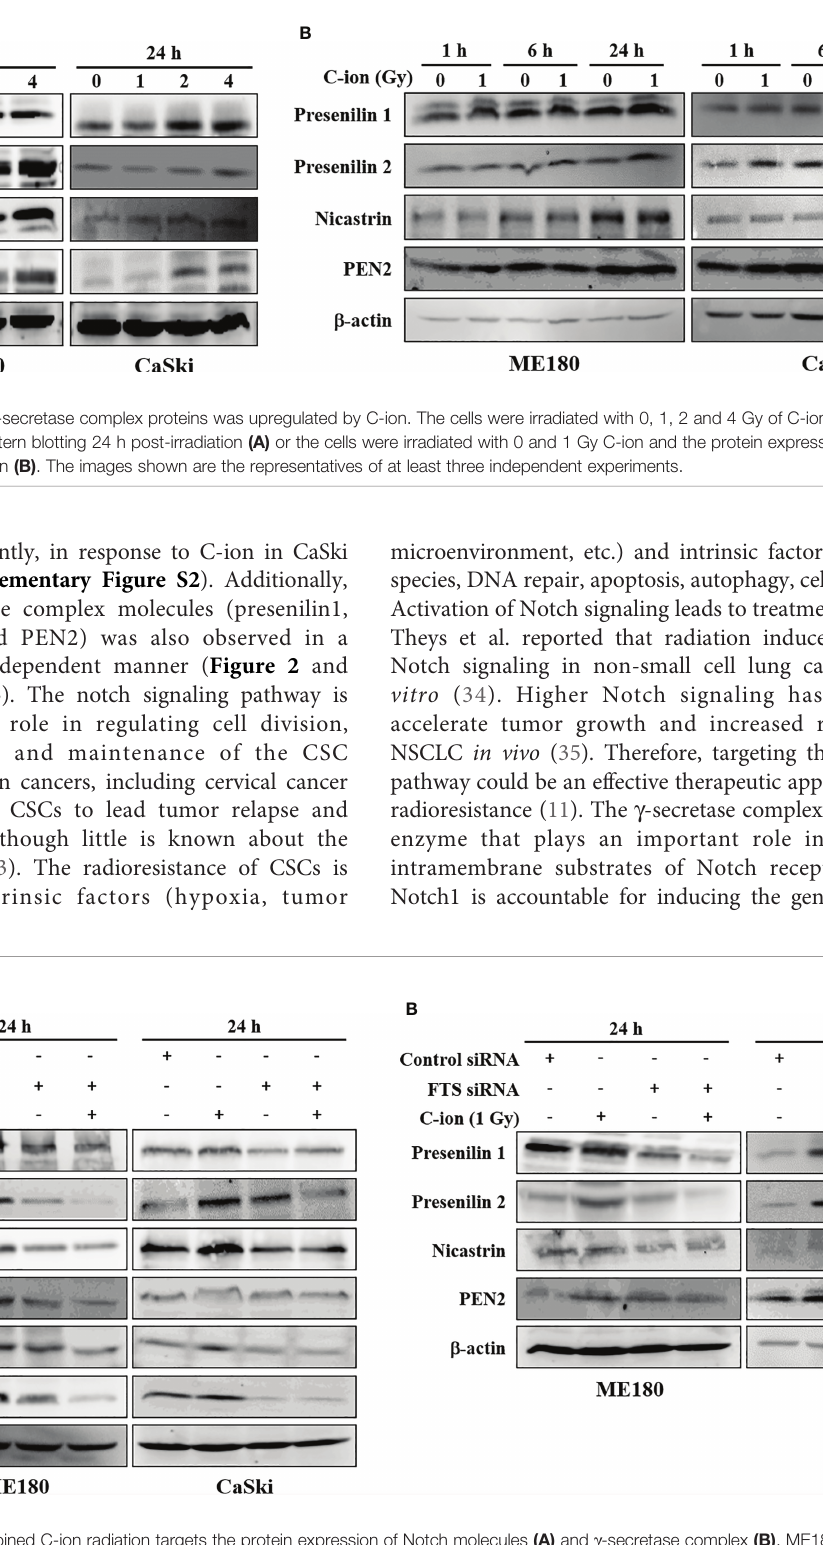
FIGURE 3 | FTS-silencing combined C-ion radiation targets the protein expression of Notch molecules (A) and g -secretase complex (B) . ME180 and CaSki cells were transfected with scrambled siRNA or FTS siRNA. Cells were irradiated with C-ion 1 Gy and the protein expression was measured with immunoblot 24 h post- irradiation. The images shown in this fi gure are the representatives of at least three independent